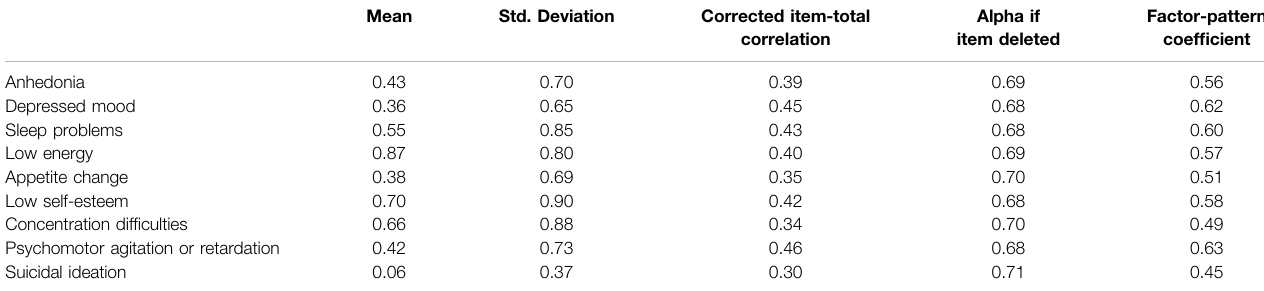
TABLE 1 | T-PHQ-9 descriptive, reliability, and factor loading statistics. Mean Std.